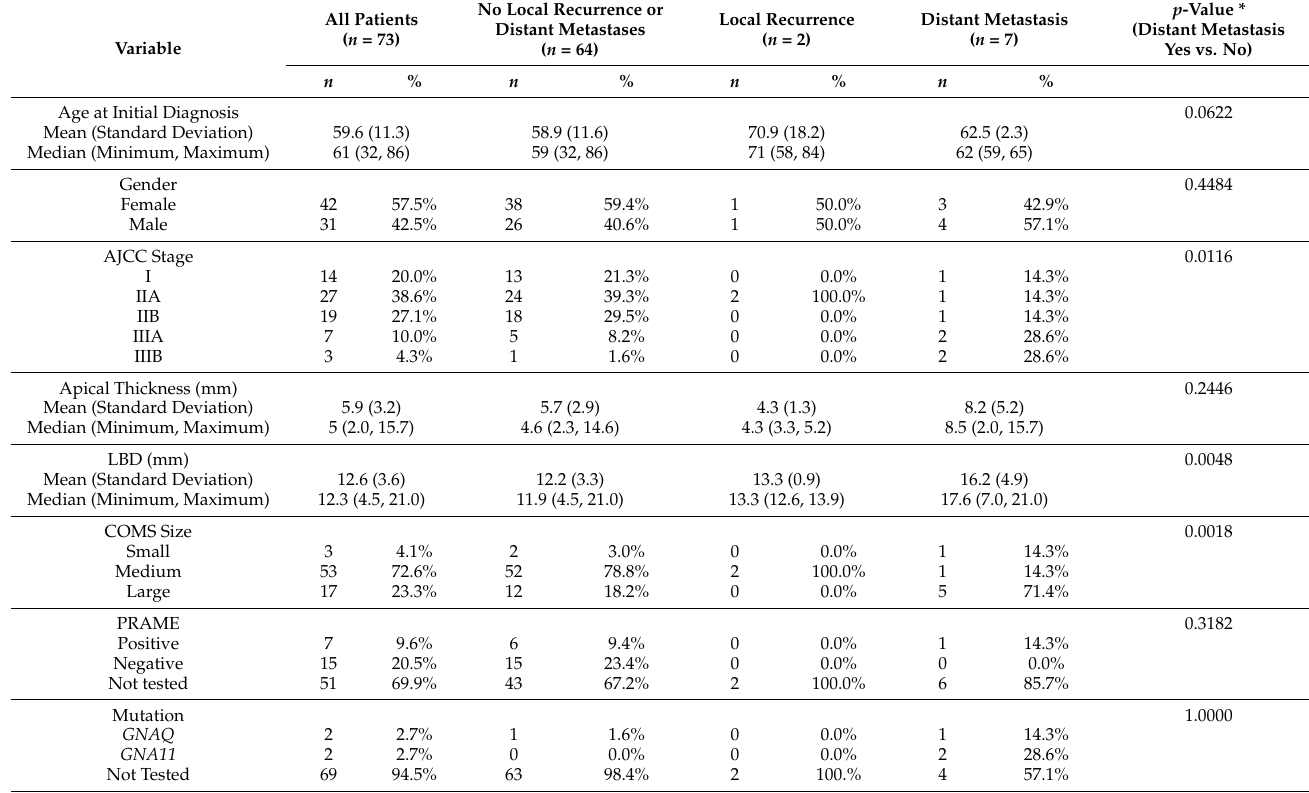
Table 1. Patient